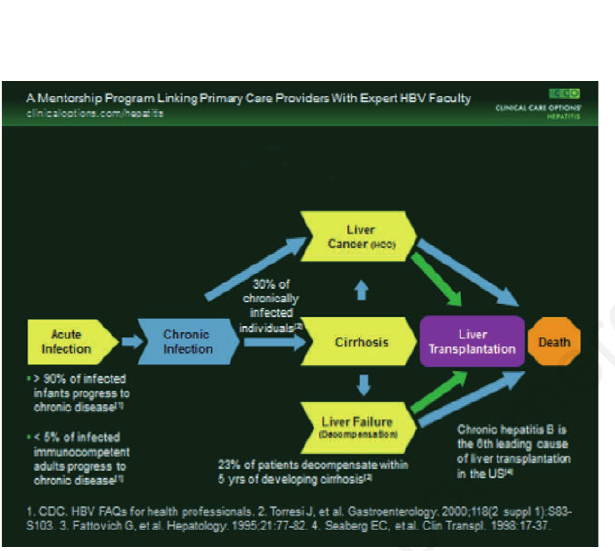
Figure 8. REVEAL: Relationship between baseline HBV DNA and cirrhosis.